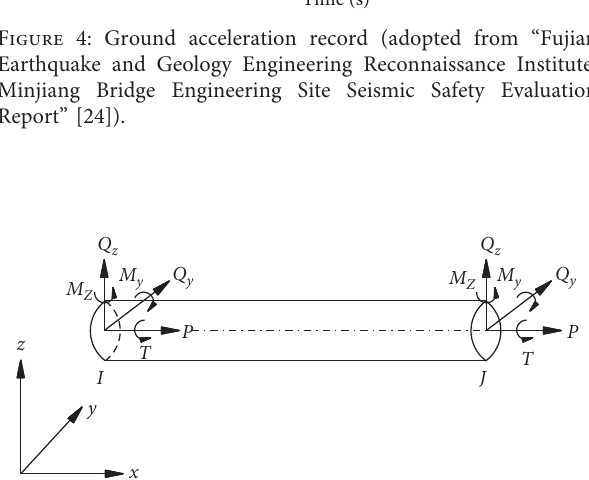
Figure 5: Force distribution of beam-column